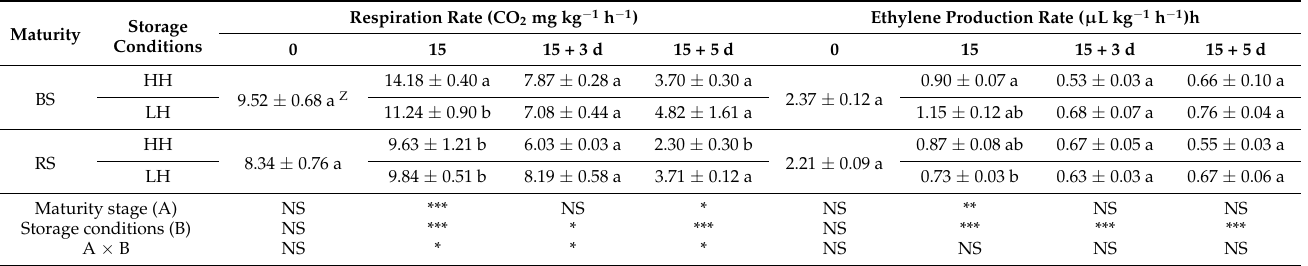
Table 2. High and low RH effects on the sweet pepper’s respiration and ethylene production rates before, after, and during 5 days of ambient conditions after 15 days of cold storage at 5 ◦ C.